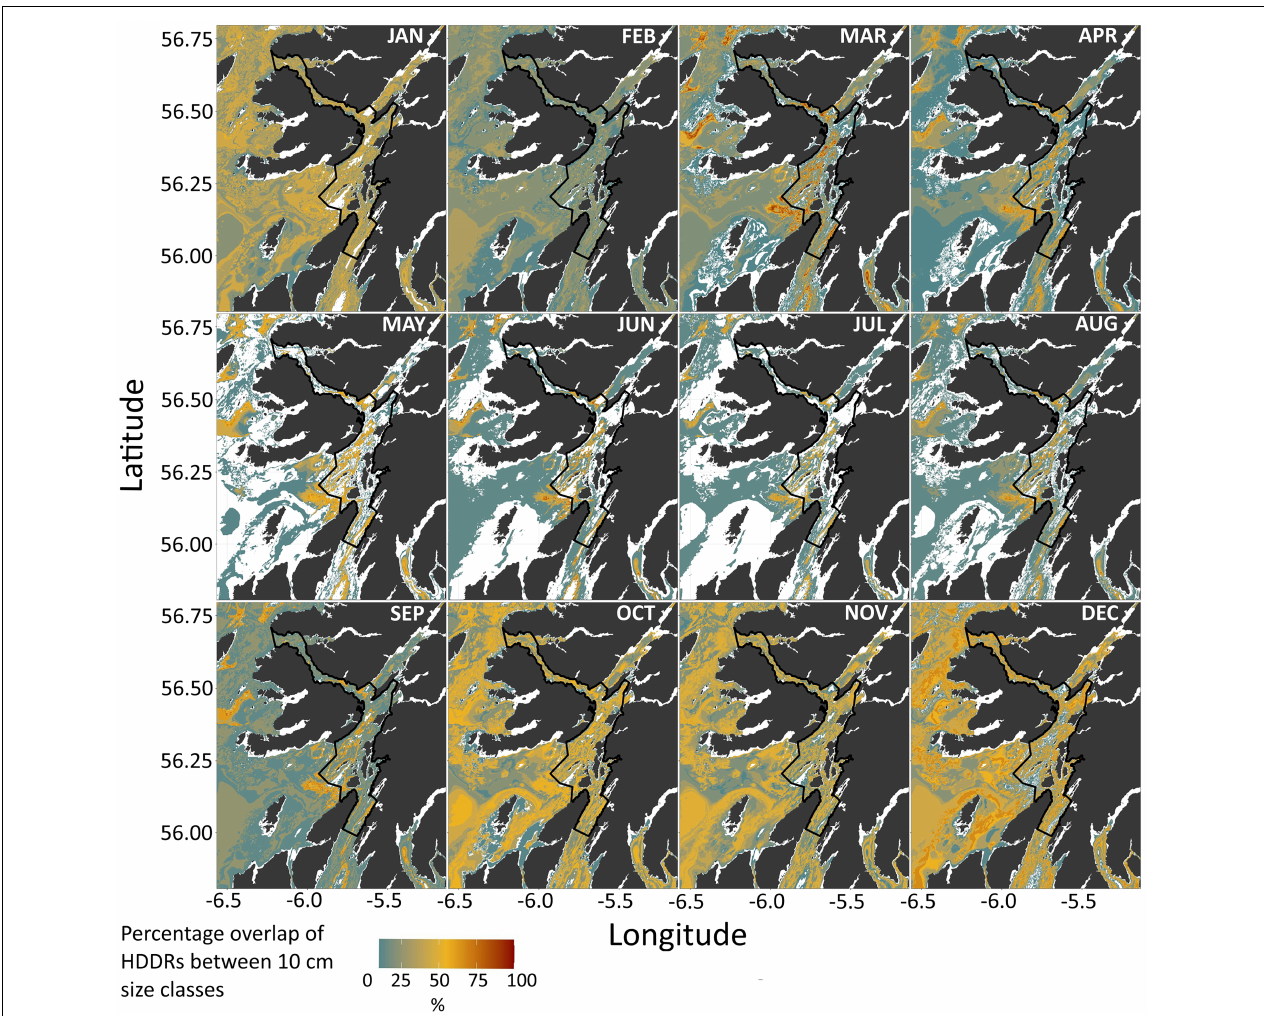
FIGURE 7 | Spatial representation of monthly core (50%) HDDRs across all size classes within the Loch Sunart to the Sound of Jura MPA management area and surrounding region. Colour reflects the number of size classes (as a percentage) whose HDDRs match the depth value in each cell. Darker values represent a higher degree of overlap, with more size classes present at the corresponding depth, while lighter colours represent a lower degree of